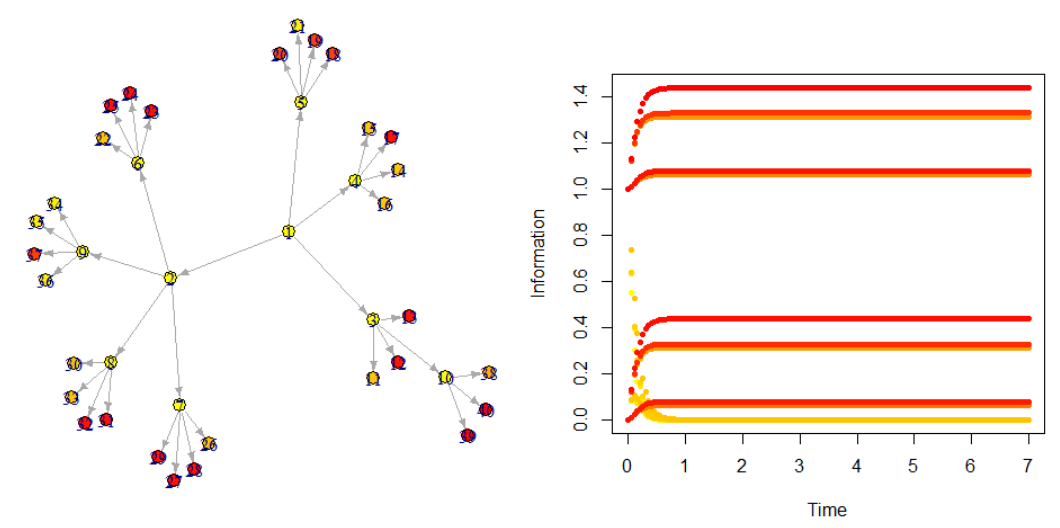
Figure 7. Diffusion on a 4-tree.